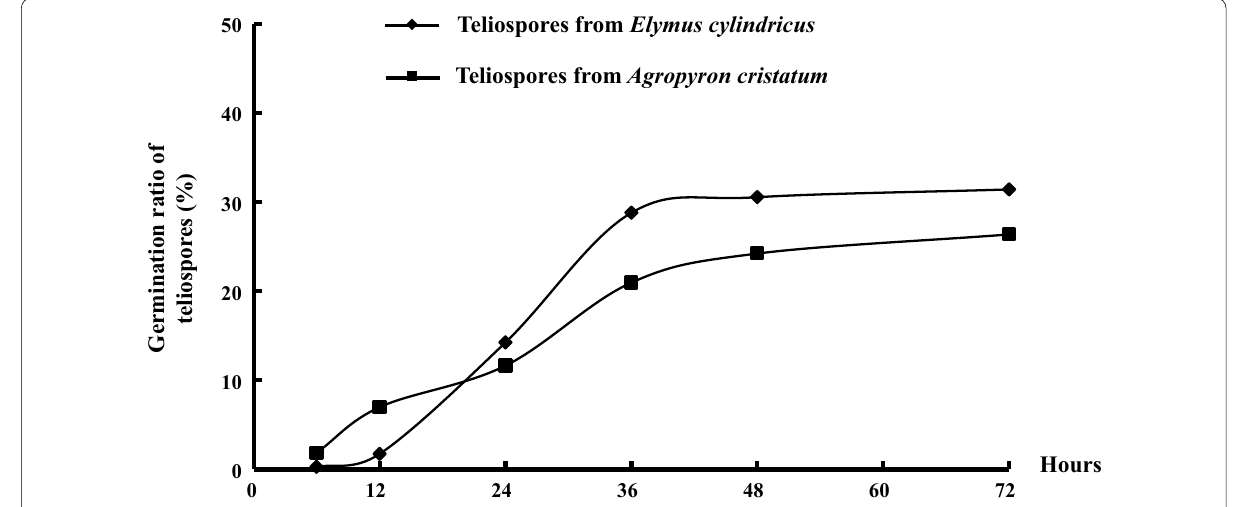
Fig. 4 Teliospore germination ratios after overwintering on grasses. Grass samples with telial sori were collected in the middle March, 2014